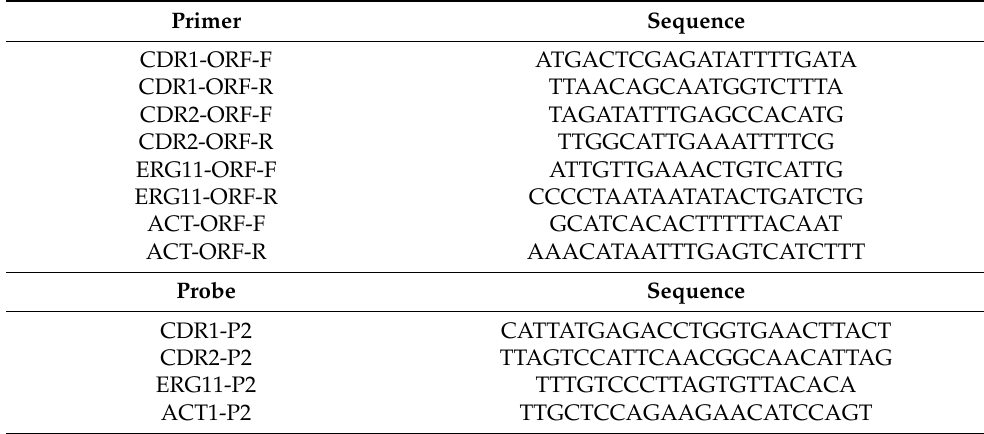
Table 3. Sequences of TaqMan primers and probes used in